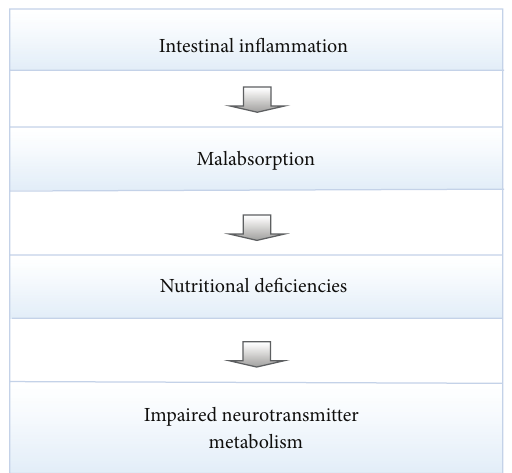
Figure 1: A potential pathophysiological mechanism associated with gluten